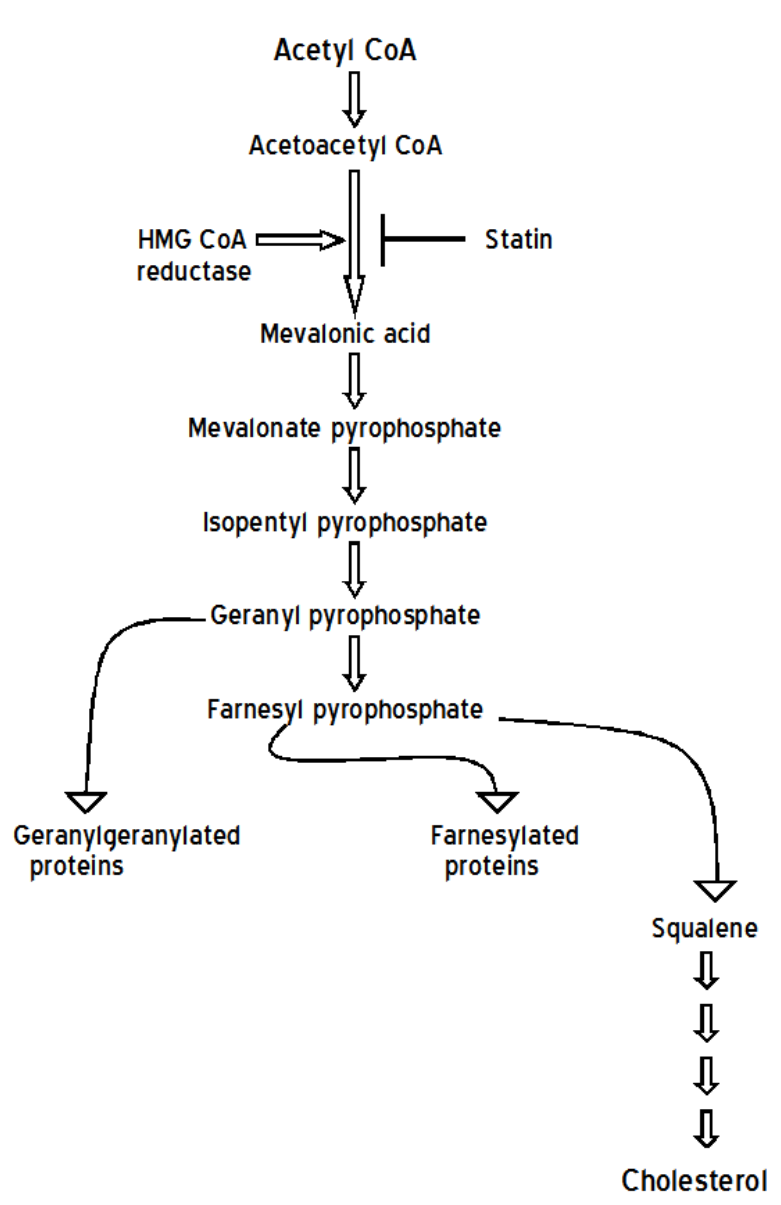
FIGURE 1. Cholesterol biosynthetic pathway. All carbon atoms in cholesterol are derived from acetyl CoA . The synthesis of mevalonic acid is catalyzed by the enzyme HMG-CoA reductase. It is the committed, rate-limiting step in cholesterol formation. This enzyme is highly regulated and the target of pharmaceutical intervention with statins. Mevalonic acid is converted to mevalonate pyrophosphate and then isopentyl pyrophosphate via ATP-requiring reactions. Six isopentyl pyrophosphates are isomerized and condensed to form squalene. The 30-carbon linear squalene undergoes cyclization to form the four rings of the steroid nucleus, with a further series of changes to yield the 27-carbon cholesterol molecule. Alternatively, through a series of other intermediates, mevalonic acid can be converted to geranyl pyrophosphate and farnesyl pyrophosphate, metabolic products that are able to supply prenyl groups for protein prenylation. Prenylated proteins have covalently linked geranylgeranyl or farnesyl groups that anchor those proteins to membranes. Prenylation is a post-translational lipid modification that affects the function of Ras, Rho, and other small